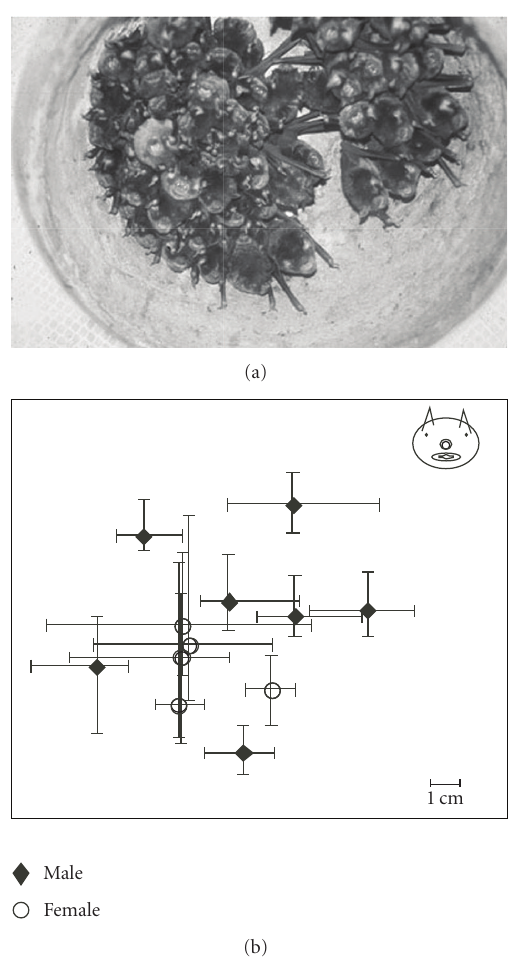
Figure 2: (a) A group of approximately 65 mustached bats roosting within an upside-down clay pot mounted in the ceiling of the flight room. (b) The range of roosting positions for mustached bats, over a two-week period, by sex. The bat’s head (top right) is drawn to scale to indicate that the farthest extent of roosting location is typically the size of the body width of an individual. Symbols (solid diamonds for males and unfilled circles for females) are located at the mean (center point) location of an individual within the roost, and the bars indicate the range of individual-specific roosting